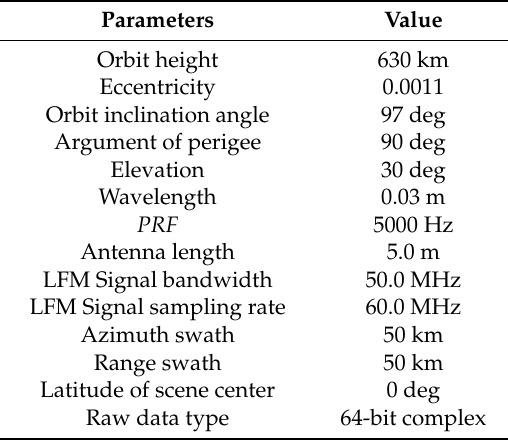
Table 1. Simulation parameters.